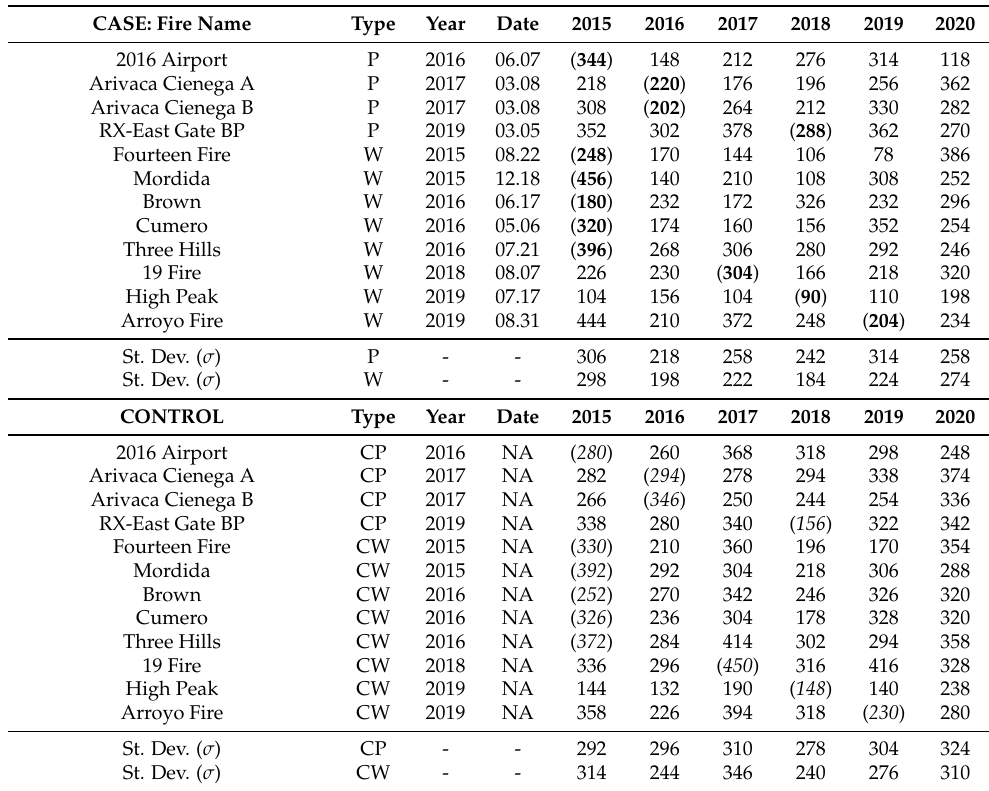
Table A2. The yearly estimated standard deviation ( σ ) of fine-fuels (kg/ha) within burn perimeters for wildfire (W) and prescribed (P) fires at BANWR, with parenthesized boldface values indicating pre- burn estimates prior to ignition (some ignition dates do not align with calendar date but rather to pre- or post-imagery dates) against 1-km buffered control (C) areas around fire perimeters (parenthesized italicized values reference ignition time period for unburned control